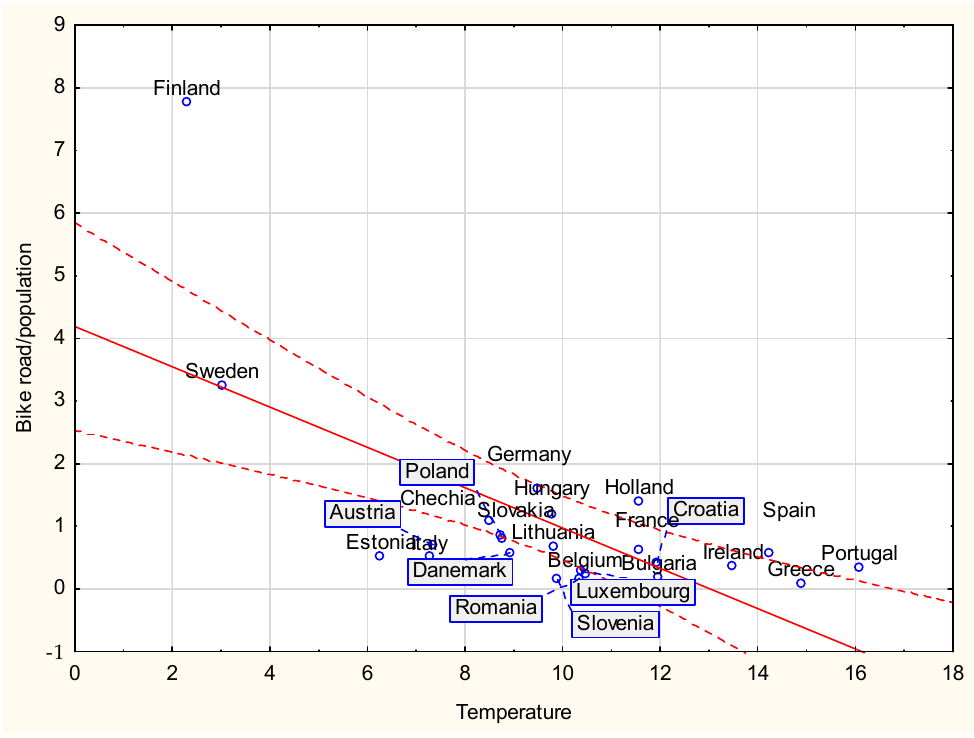
Figure 7. Scatter plot between the country’s average temperature and the average length of bike lanes per 1000 residents in the smart cities. Source: author’s analysis. Based on the collected data, the relationship between average bike road length in a smart city area in a country and average temperature can be expressed by the following formula: The average bike road length in a smart city = 1849,24–130,634*average temperature The sca tt er plot (Figure 5) shows that most countries fall within the range of 0.95 in terms of the relationship between the country’s average temperature and the average length of bicycle routes in smart cities. When analyzing the data, it is worth noting the following groups of countries: •